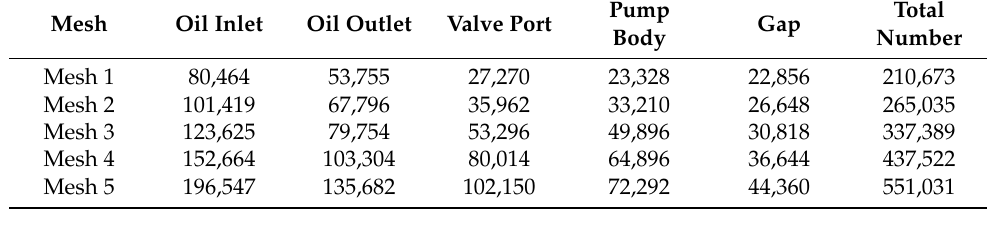
Table 2. Number of mesh in each part of the fluid model.